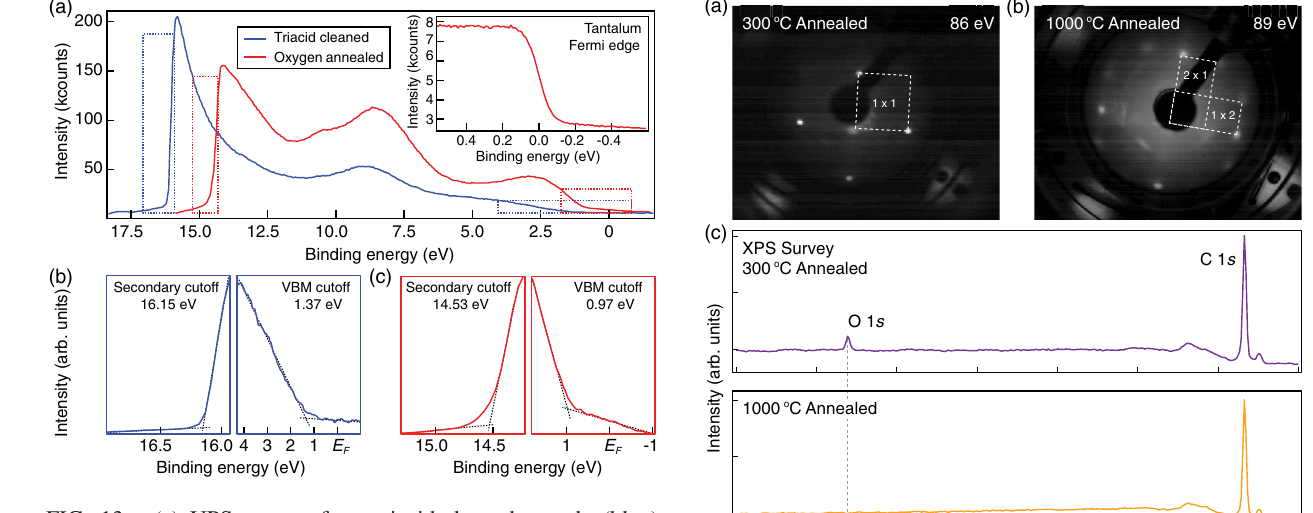
FIG. 13. (a) UPS spectra from triacid-cleaned sample (blue) and oxygen-annealed sample (red) as a function of binding energy relative to the Fermi level. The Fermi level is calibrated with a reference tantalum foil (inset). The spectral width ω is calculated as the energy difference between the secondary electron cutoff and valence band maximum, indicated by the dashed rectangles. (b),(c) Enlargement of the secondary electron cutoff and the valence band maximum for the triacid-cleaned sample and the oxygen-annealed sample, respectively. Fig. 13(a)]. The binding energy scale was calibrated to the core levels and Fermi edge of a tantalum calibration sample [Fig. 13(a), inset]. The width of the electron distribution curve ω can be measured as the energy difference between the valence band maximum (VBM) and the secondary electron cutoff at high binding energy, as shown in